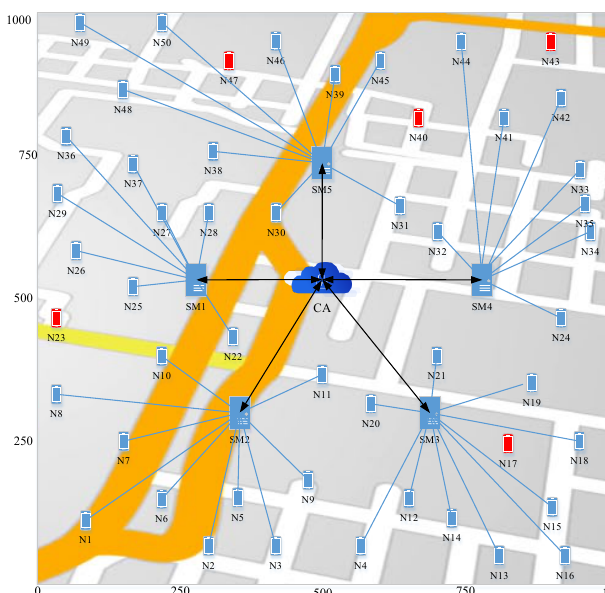
Figure 5 . Simulation environment of MANET-IoT